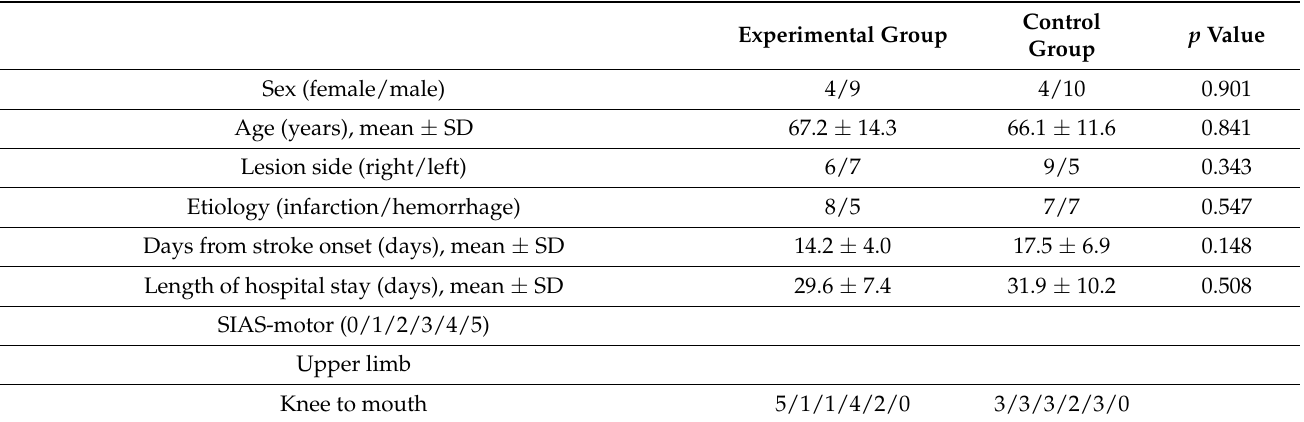
Table 1. Demographic characteristics of the participants at